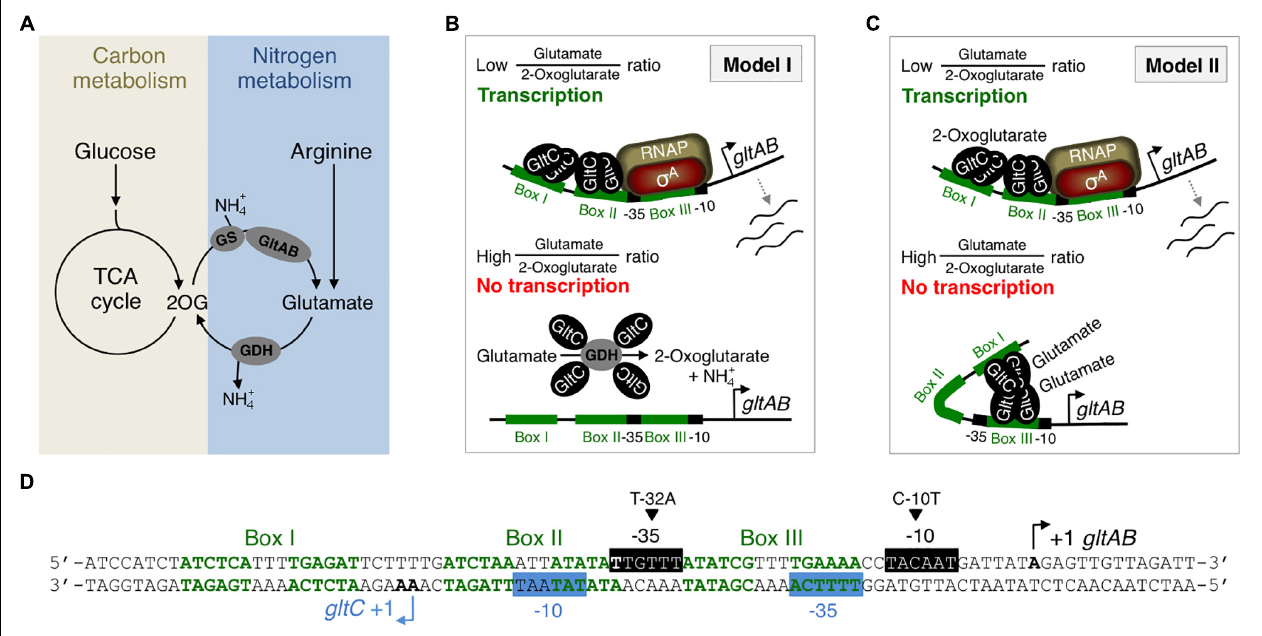
FIGURE 1 | (A) Reactions connecting carbon with nitrogen metabolism in B. subtilis . (B,C) Models for the regulation of gltAB expression based on in vivo and in vitro studies, respectively (Commichau et al., 2007a; Picossi et al., 2007). (D) Part of the gltC-gltAB intergenic region showing the –10 and –35 elements of the P gltC (blue) and P gltA (black) promoters, as well as boxes I, II, and III that are bound by GltC. Bent arrows indicate transcription start sites. Point mutations affecting the activity of the P gltA promoter are indicated by triangles. GS, glutamine synthetase; GltAB, glutamate synthase; Glu, glutamate; 2-OG, 2-oxoglutarate; RNAP, RNA polymerase; RocG and GudB1, paralogous GDHs; σ A , housekeeping sigma factor A; TCA, tricarboxylic